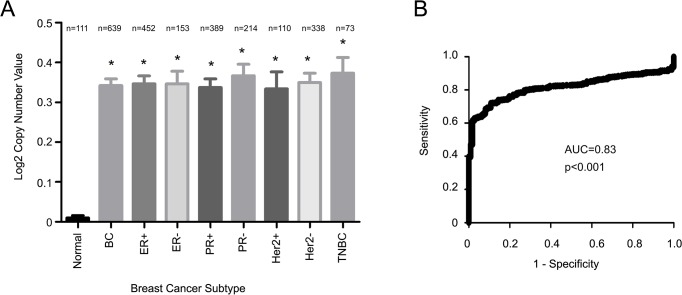
Amplification of SIPL1 in breast cancer.Data from the TCGA 2 dataset was extracted from Oncomine (Compendia Bioscience, Ann Arbor, MI) and analyzed with respect to SIPL1 gene copy number variation (GCN) in cancer vs. normal tissues. Statistical analysis was conducted using an unpaired, two-tailed, welch-corrected t-test. Asterisks indicate p<0.0001 in comparison the normal breast tissues. A Log2 copy number unit of 0 equates to a gene copy number of 2 (A). (B) A receiver-operating characteristic (ROC) curve of normal versus primary breast cancer was calculated based the data extracted from the TCGA dataset. AUC: area under the curve.